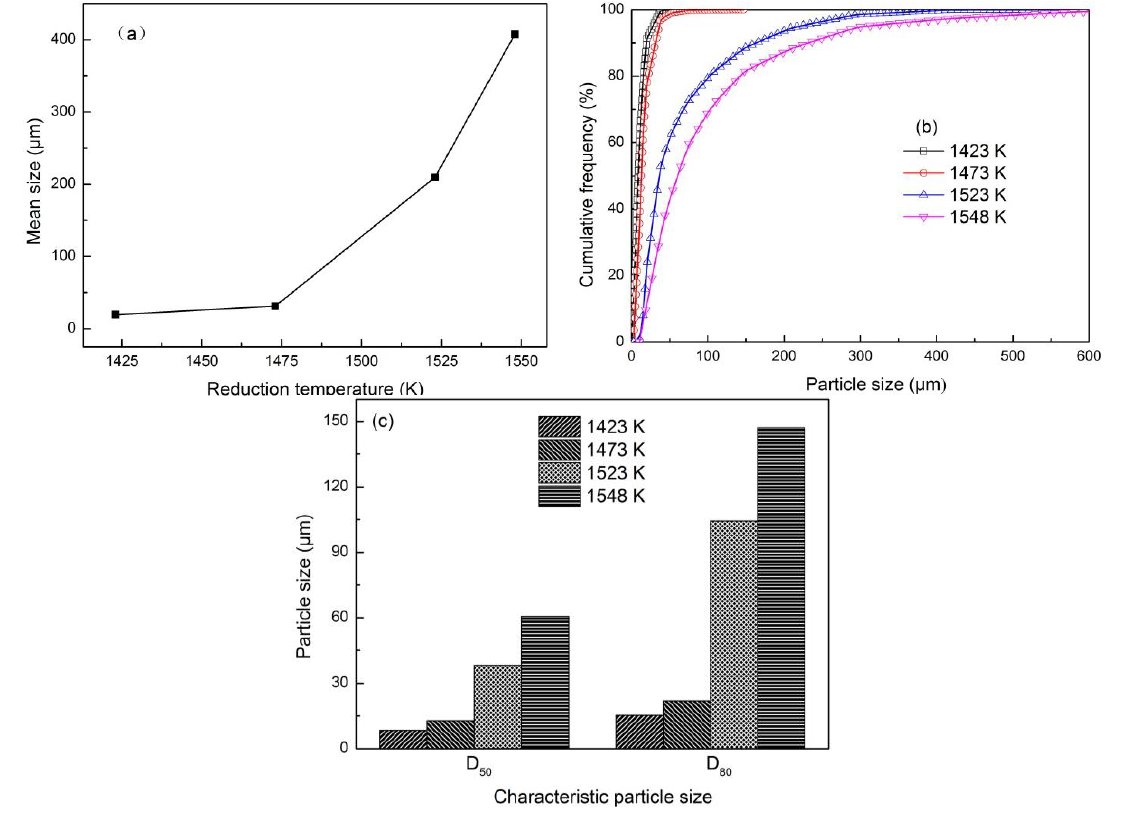
Figure 6. Effect of reduction temperature on iron particle size at reduction time of 30 min and −2 mm oolitic hematite particle size: ( a ) Mean size; ( b ) cumulative frequency distribution; ( c ) characteristic particle size.